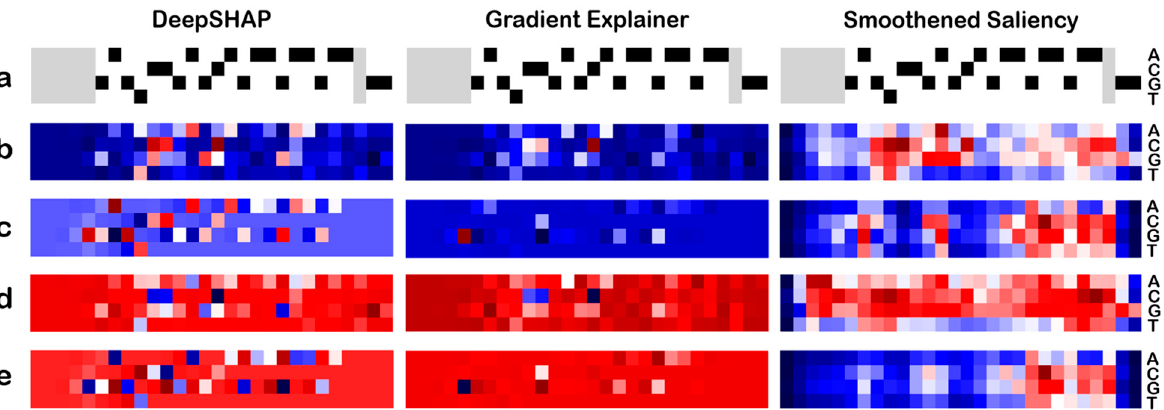
Figure 6. Average activation maps. EMX1 locus is shown as a representative example. ( a ) The EMX1 target sequence. Average activation maps of the ( b ) positive o ff -target sequences, ( c ) positive class get sequence. Average activation maps of the ( b ) positive off-target sequences, ( c ) positive class reference reference target sequences, ( d ) negative o ff -target sequences, and ( e ) negative class reference target target sequences, ( d ) negative off-target sequences, and ( e ) negative class reference target sequences.